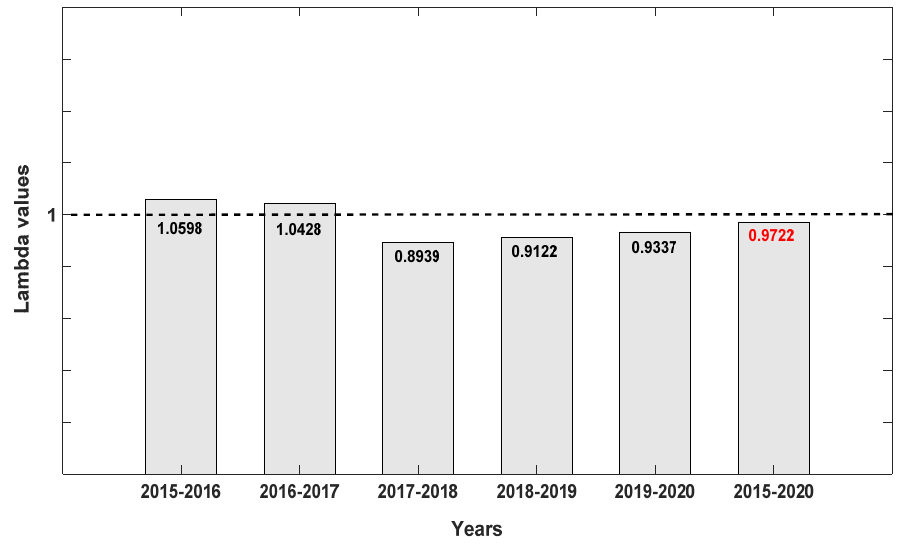
Figure 3. Lambda ( λ ) values for each pair of years and for the period 2015–2020 for all seven Dendrophylax lindenii populations within the Florida Panther National Wildlife Refuge. Note that the Lambda values ( λ ) indicate an increase in the first two years followed by a noticeable decrease ( λ = 0.8939) in the third year (2017–2018). The figure shows a progression towards recovery during the last three years, but λ remains <1.